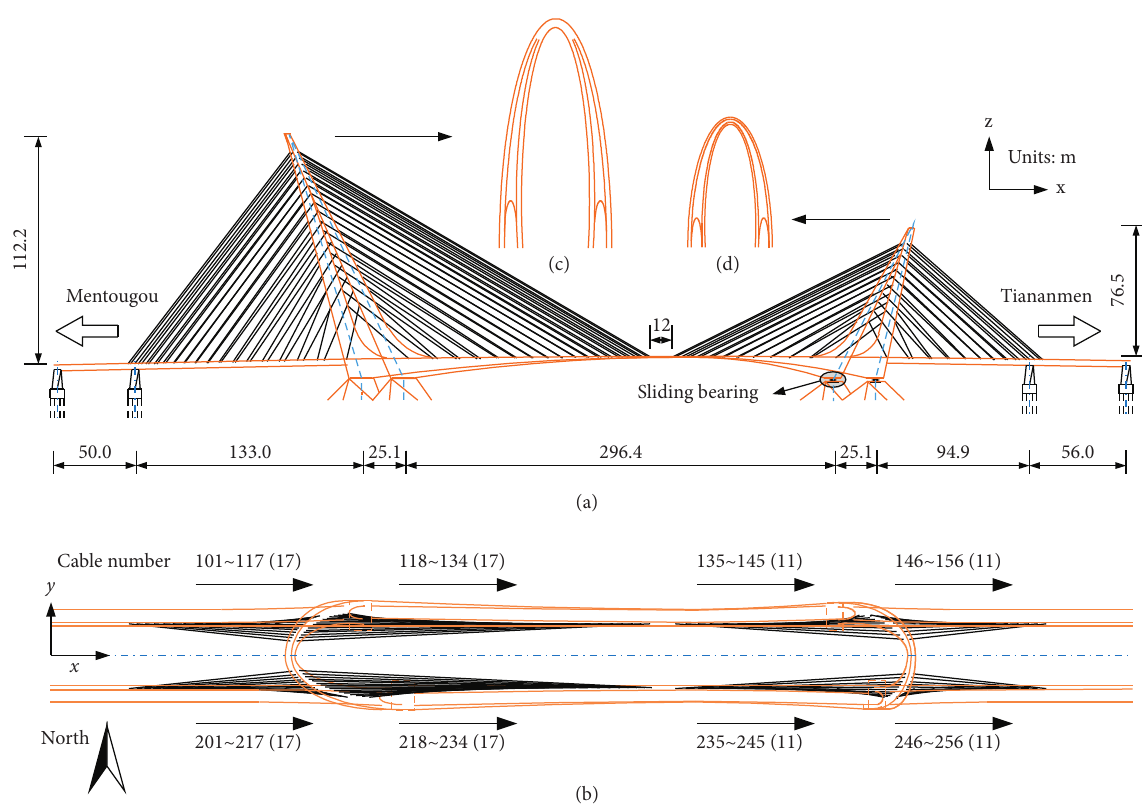
Figure 10: Sketch of the Yong-ding cable-stayed bridge. (a) Main view. (b) Top view. (c) Side view of the high tower. (d) Side view of the low